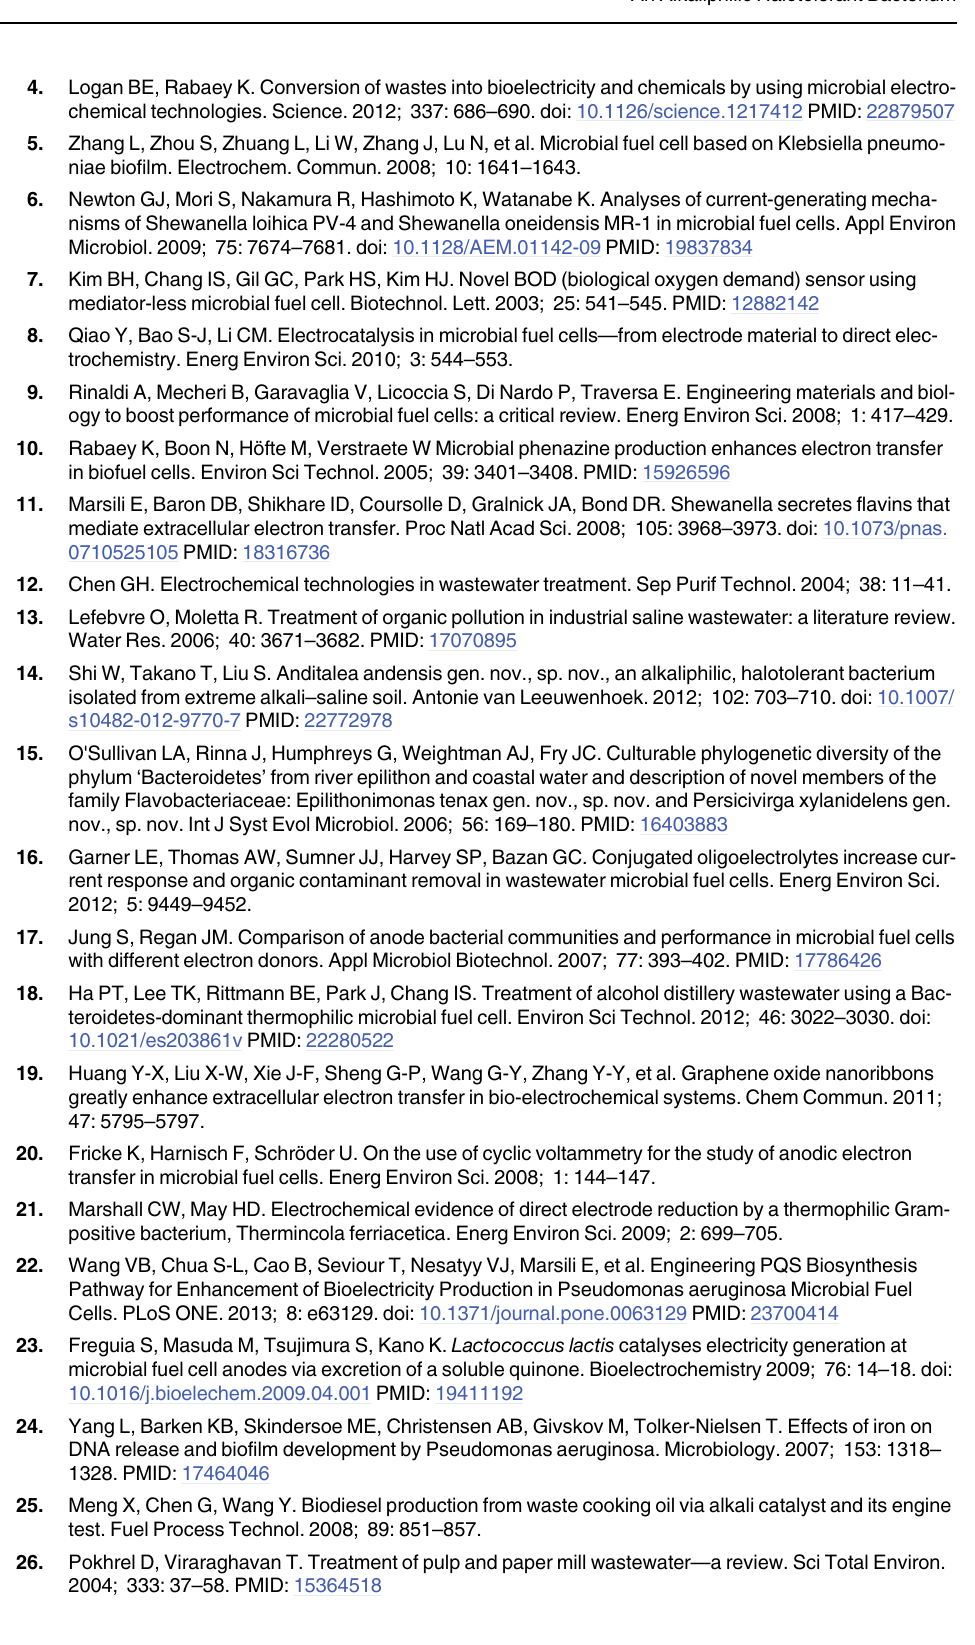
PLOS ONE | DOI:10.1371/journal.pone.0132766 July 14,